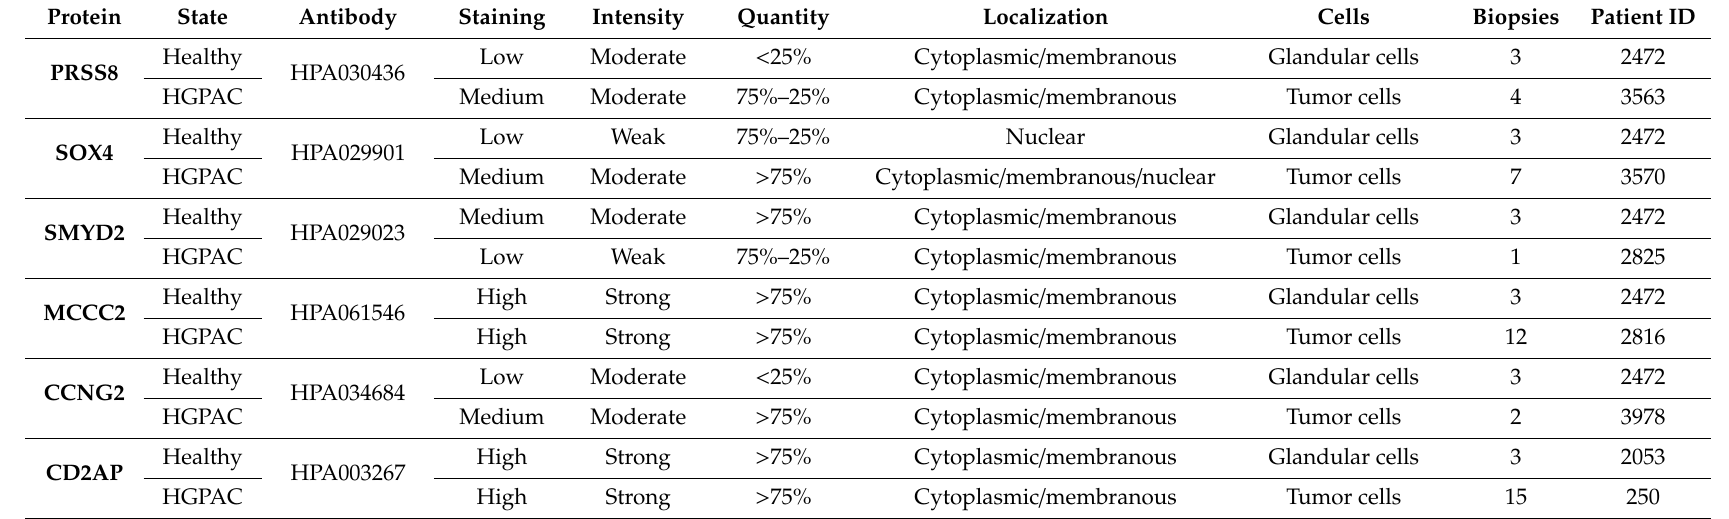
Table 1. Immunostaining details recovered from The Human Atlas